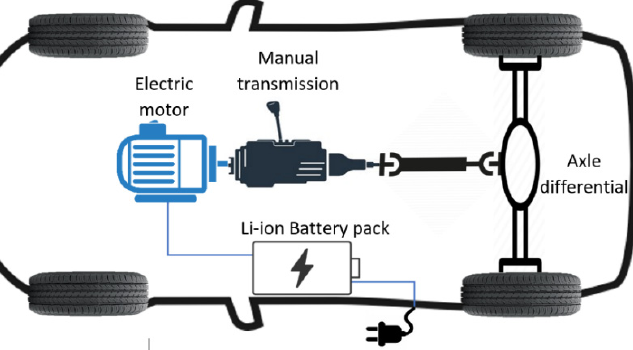
Figure 6. Test car for data gathering.